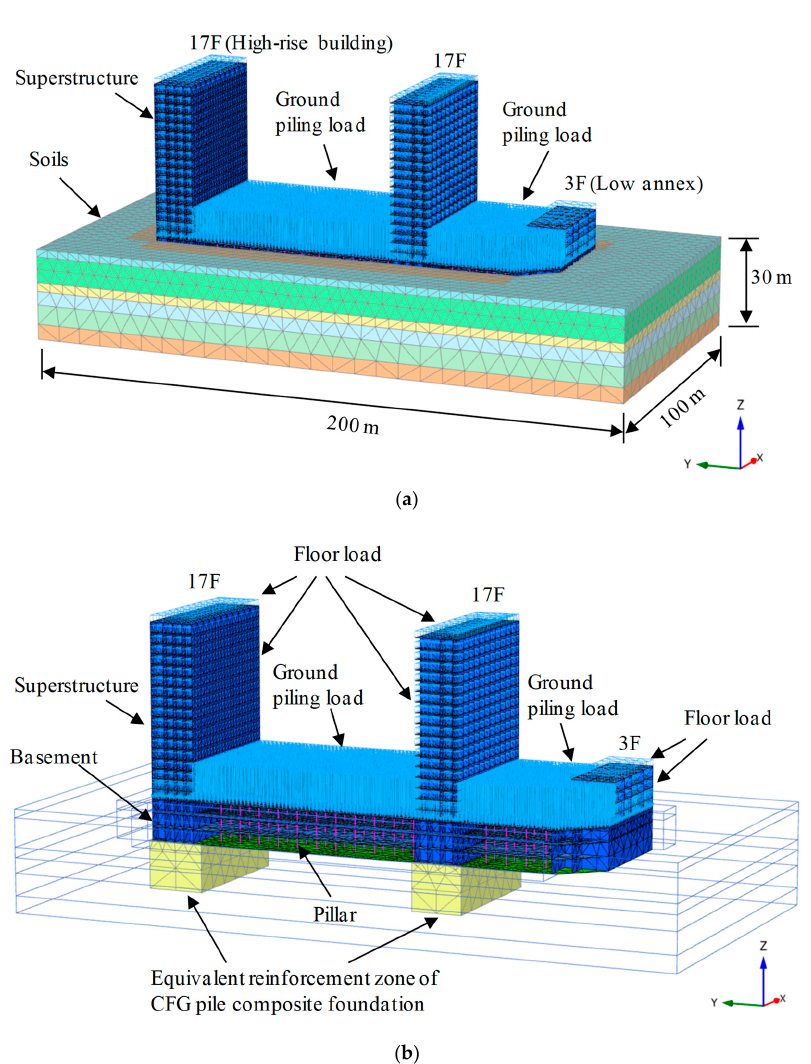
Figure 15. 3D model for foundation reinforcement of high-rise buildings: ( a ) integral mesh; ( b ) superstructure, basement, and high-rise foundation reinforcement area grid.